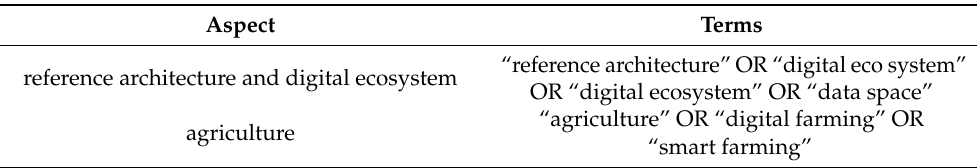
Table 1. Aspects covered by the search string, along with the chosen terms